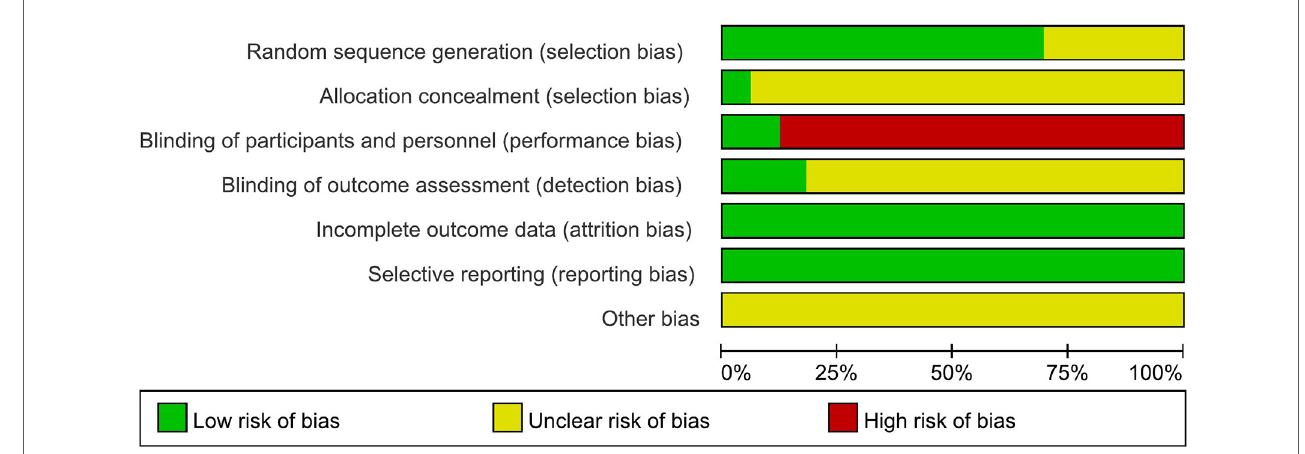
FIGURE 2 Risk of bias graph.